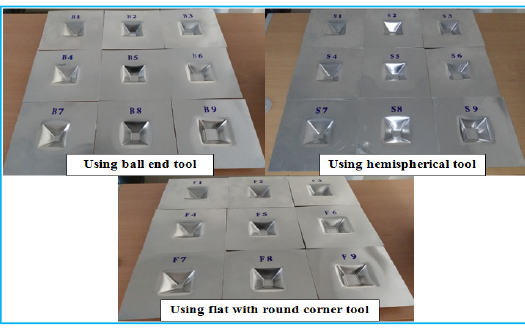
Fig. 6. CNC milling machine utilized in experimental work.